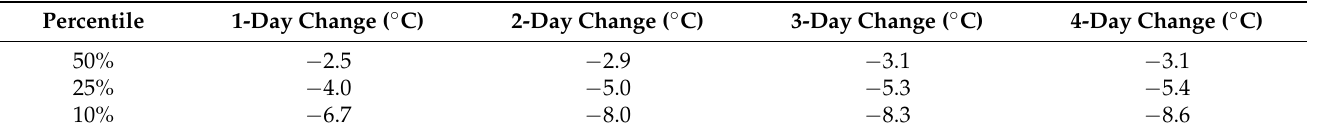
( c ) Figure 7. Cumulative distribution of cold surge indicators of all cold events: ( a ) 𝑇 , ( b ) ∆𝑇 and ( c ) 𝑤 . The corresponding values of the 50th (50th), 25th (75th) and 10th (90th) percentiles for 𝑇 , ∆𝑇 , ( 𝑤 ) are marked.